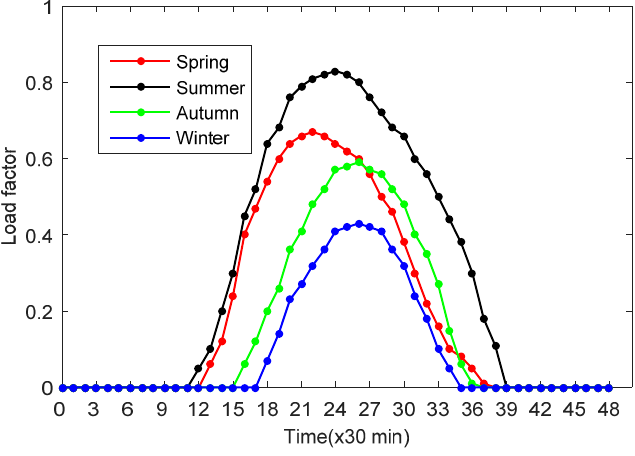
Figure 6. The typical timing characteristic curves of photovoltaic output for the four seasons.